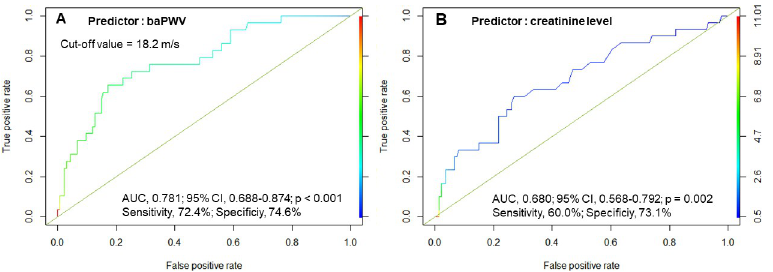
Fig 4. Comparison of receiver operating characteristic curves in the selection of predictors of postoperative acute kidney injury. AUC, area under the curve; CI, confidence interval; PWV, pulse wave velocity.